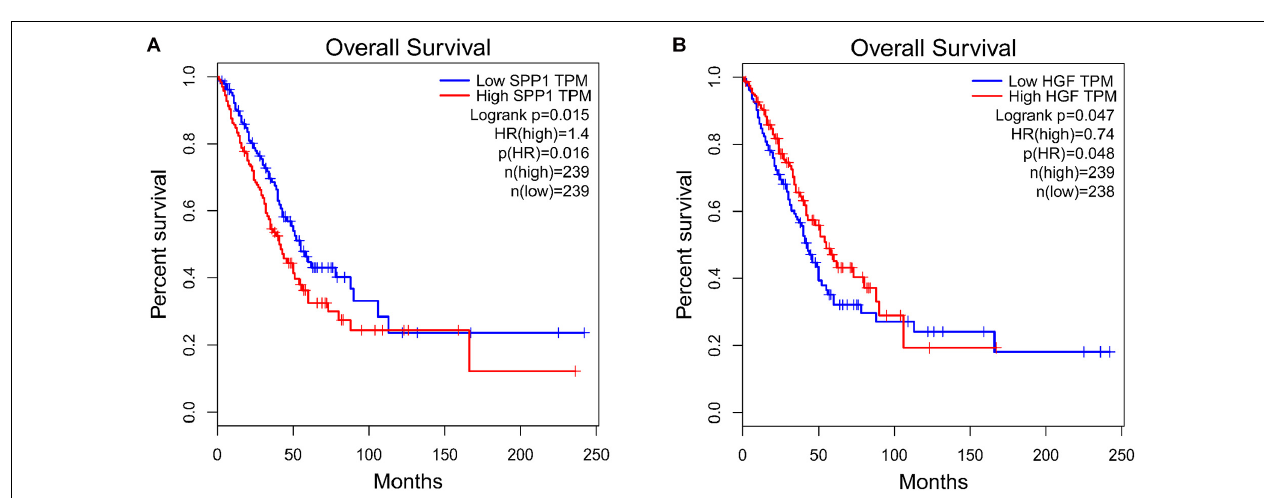
FIGURE 6 | The network of key mRNAs. (A) The network diagram of the top ten hub miRNAs and (B) the rank and score of the top ten hub mRNAs in the PPI network. PPI, protein–protein interaction; miRNA, microRNA; mRNA, messenger RNA; NOTCH1, neurogenic locus notch homolog protein 1; MMP2, matrix metalloproteinase 2; IGF1, insulin-like growth factor 1; KDR, kinase-insert domain-containing receptor; SPP1, secreted phosphoprotein 1; FLT-1, vascular endothelial growth factor receptor 1; HGF, hepatocyte growth factor; TEK, angiopoietin-1 receptor; ANGPT1,angiopoietin-1 gene; PDGFB, platelet-derived growth factor-beta.